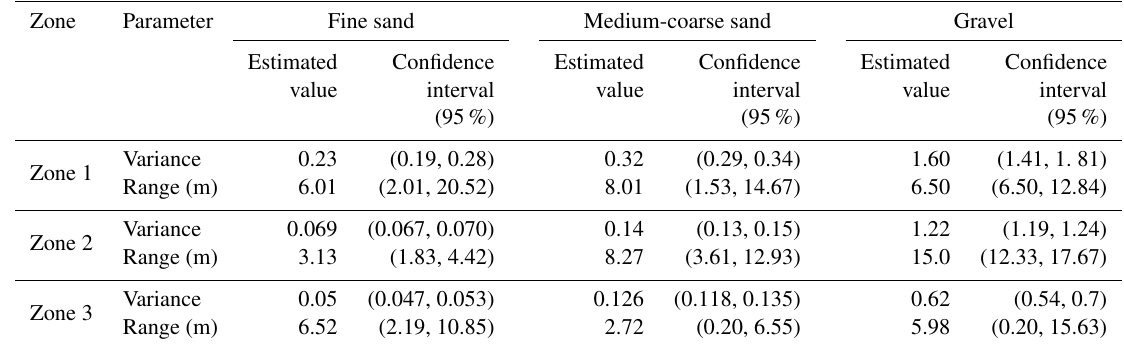
Figure 6. Experimental (circle symbol) and model (solid line) semivariogram along the vertical direction for the various hydrofacies in the three zones. Notice that the range in the y axis differs for gravel lithology. Table 3. Optimized parameters in the fitting exponential function of log 10 (K) semivariogram in vertical direction for the various facies and